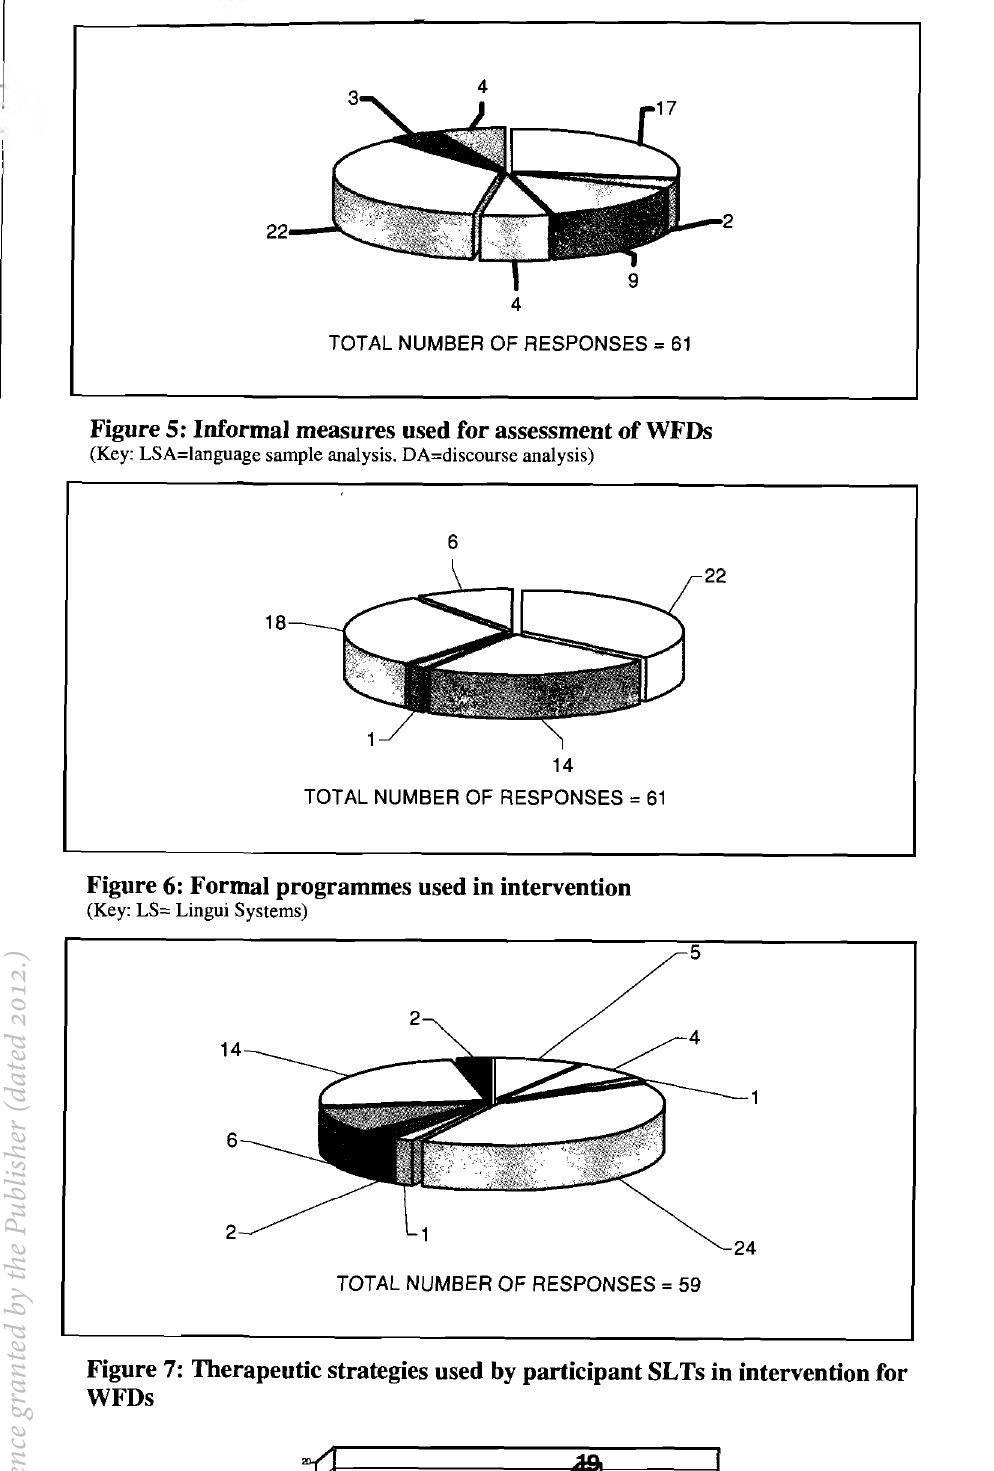
Figure 7: Therapeutic strategies used by participant SLTs in intervention for WFDs